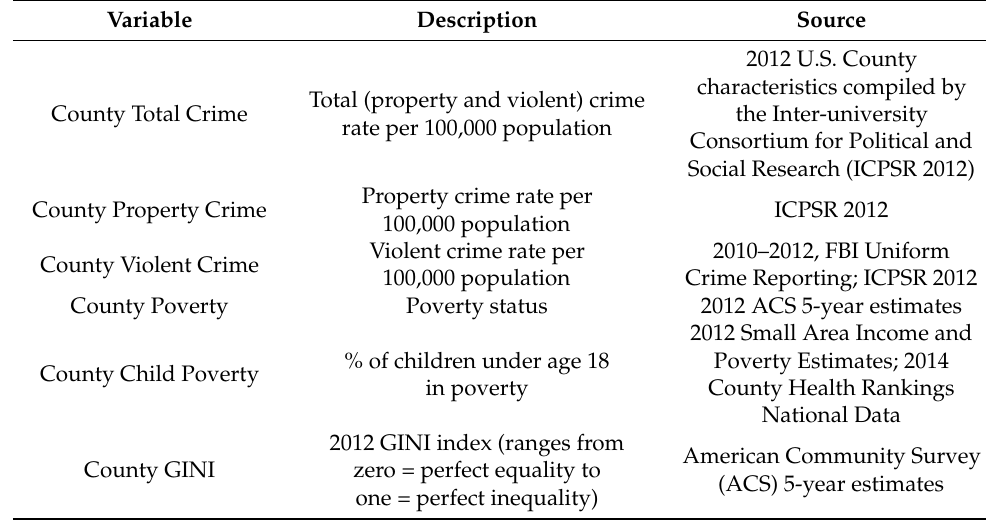
Table A8. Other social